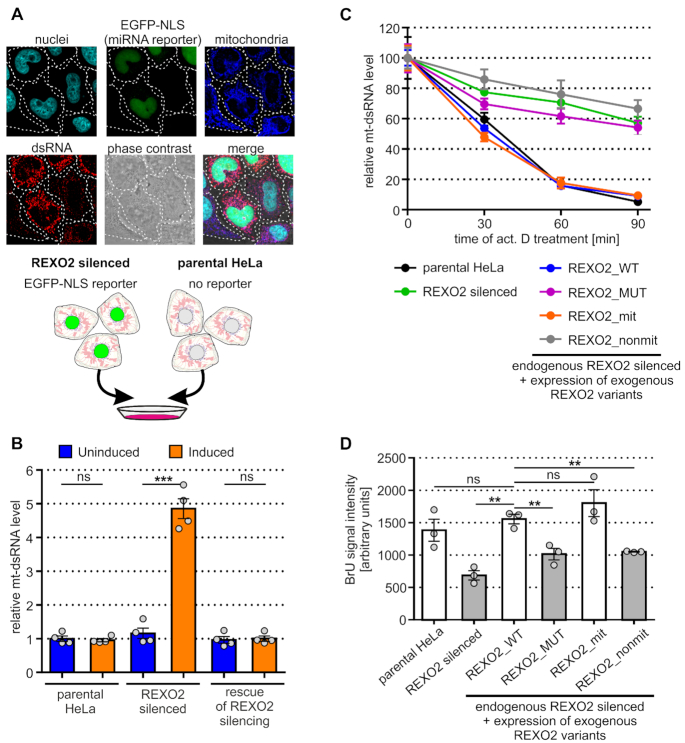
REXO2 silencing results in the accumulation of dsRNA in mitochondria. (A) Immunofluorescence analysis of dsRNA levels in parental and REXO2-depleted HeLa cells. A schematic representation of the experimental design is shown in the bottom part of the panel. dsRNA-specific J2 antibodies were used. Nuclei and mitochondria were stained with Hoechst and MitoTracker DeepRed, respectively. (B) Quantitative analysis of mt-dsRNA levels in the studied cell lines using automated fluorescence microscopy. Measurements were performed 3 days after miRNA and transgene expression induction. Bars show mean ± SEM of total mt-dsRNA foci intensity values calculated from tetraplicates, where in each replicate >1200 cells were analyzed. Mean of each replicate is shown as a dot. (C) Analysis of mt-dsRNA stability. The indicated cells were treated (or not) with actinomycin D, and mt-dsRNA levels were measured using J2 immunostaining. Mean (±SEM) of total intensity values of mt-dsRNA foci are shown. Four replicates were analyzed (each replicate > 500 cells). (D) Measurement of mtDNA transcription. The indicated cells were cultured in the presence of BrU and the amount of BrU that was incorporated into mitochondrially localized RNAs was quantified by anti-BrU immunostaining and fluorescent microscopy. Bars show the mean of the replicates ± SEM. Dots represent means of replicates (> 650 cells in each replicate). A two-tailed unpaired t-test was applied (***P < 0.001, **P 0.001 to 0.01, ns – not significant P > 0.05).